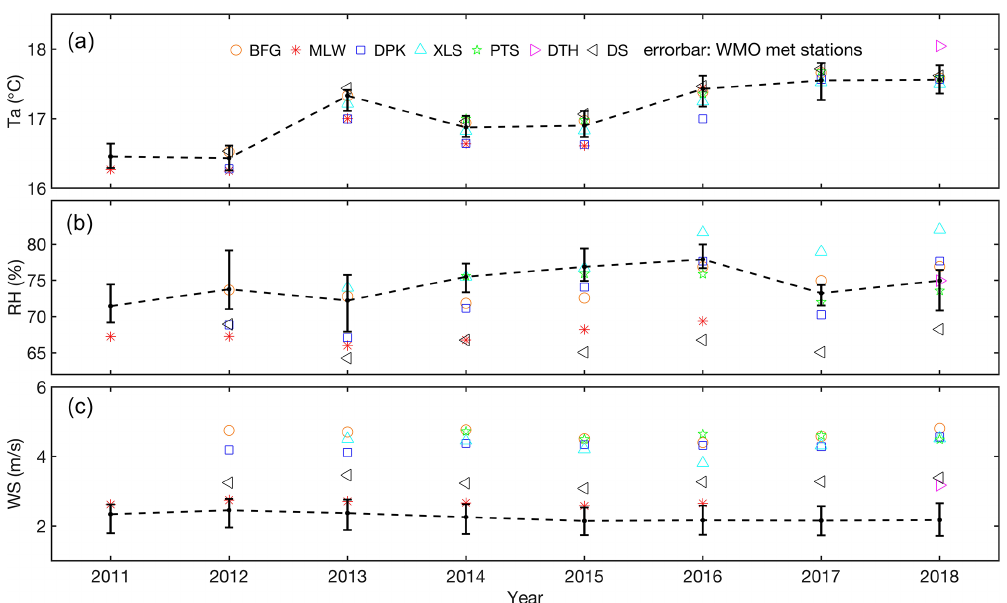
Figure 5. Annual mean air temperature (a) , relative humidity (b) and wind speed (c) observed at the eddy flux sites (symbols) and at the four WMO weather stations around the lake (line). Error bars represent the range of the annual means of the four WMO stations.